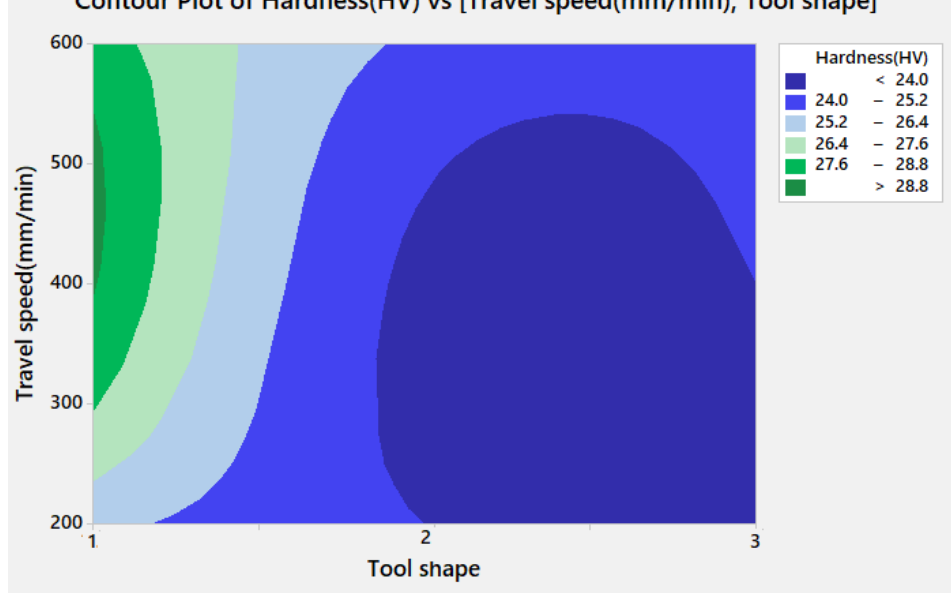
Figure 12. Contour plot for hardness against travel speed and tool shape.